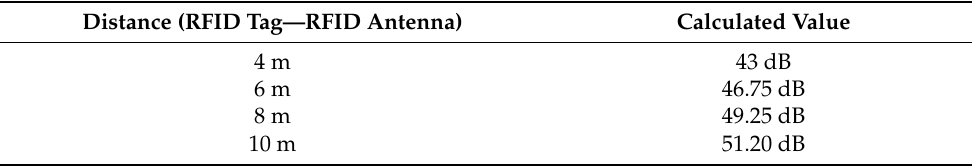
Table 3. Free-space path loss for considered reading distances.